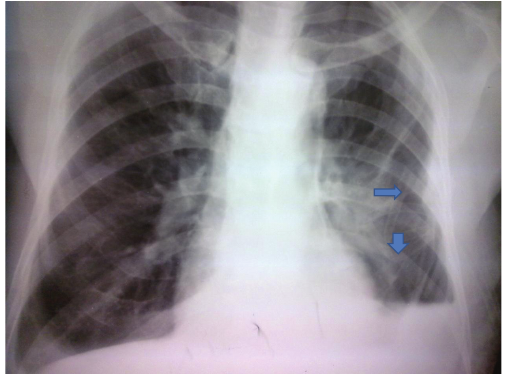
Figure 3: Kinking of chest